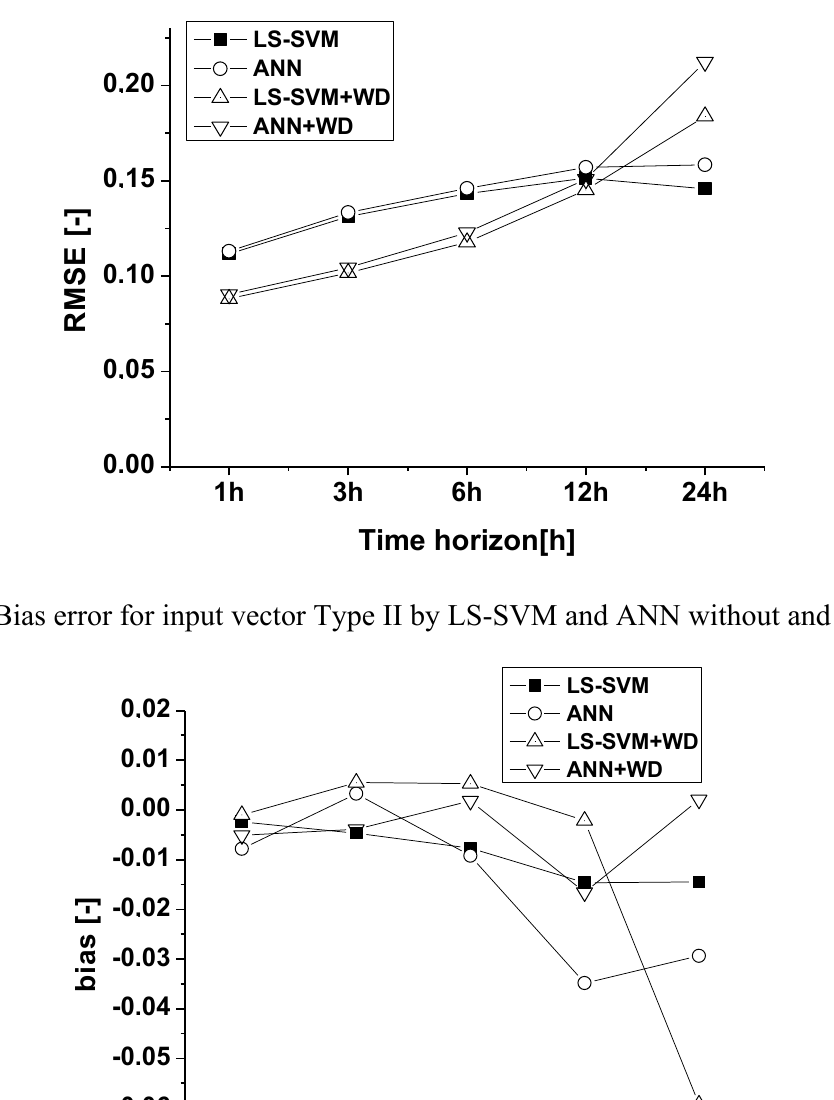
Figure 6. RMSE for input vector Type II by LS-SVM and ANN without and with WD.